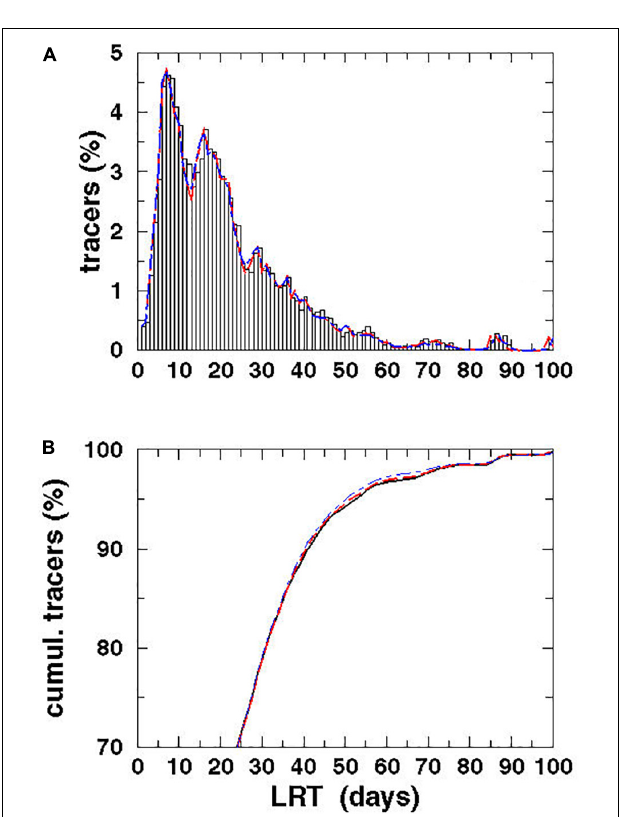
FIGURE 11 | Spectrum (A) and cumulative spectrum (B) of the Lagrangian tracers (%) vs. the LRT for the water of the VR for different diffusion velocities: P = 0 m/s (black), P = 0.1 m/s (red dashed), and P = 0.2 m/s (blue